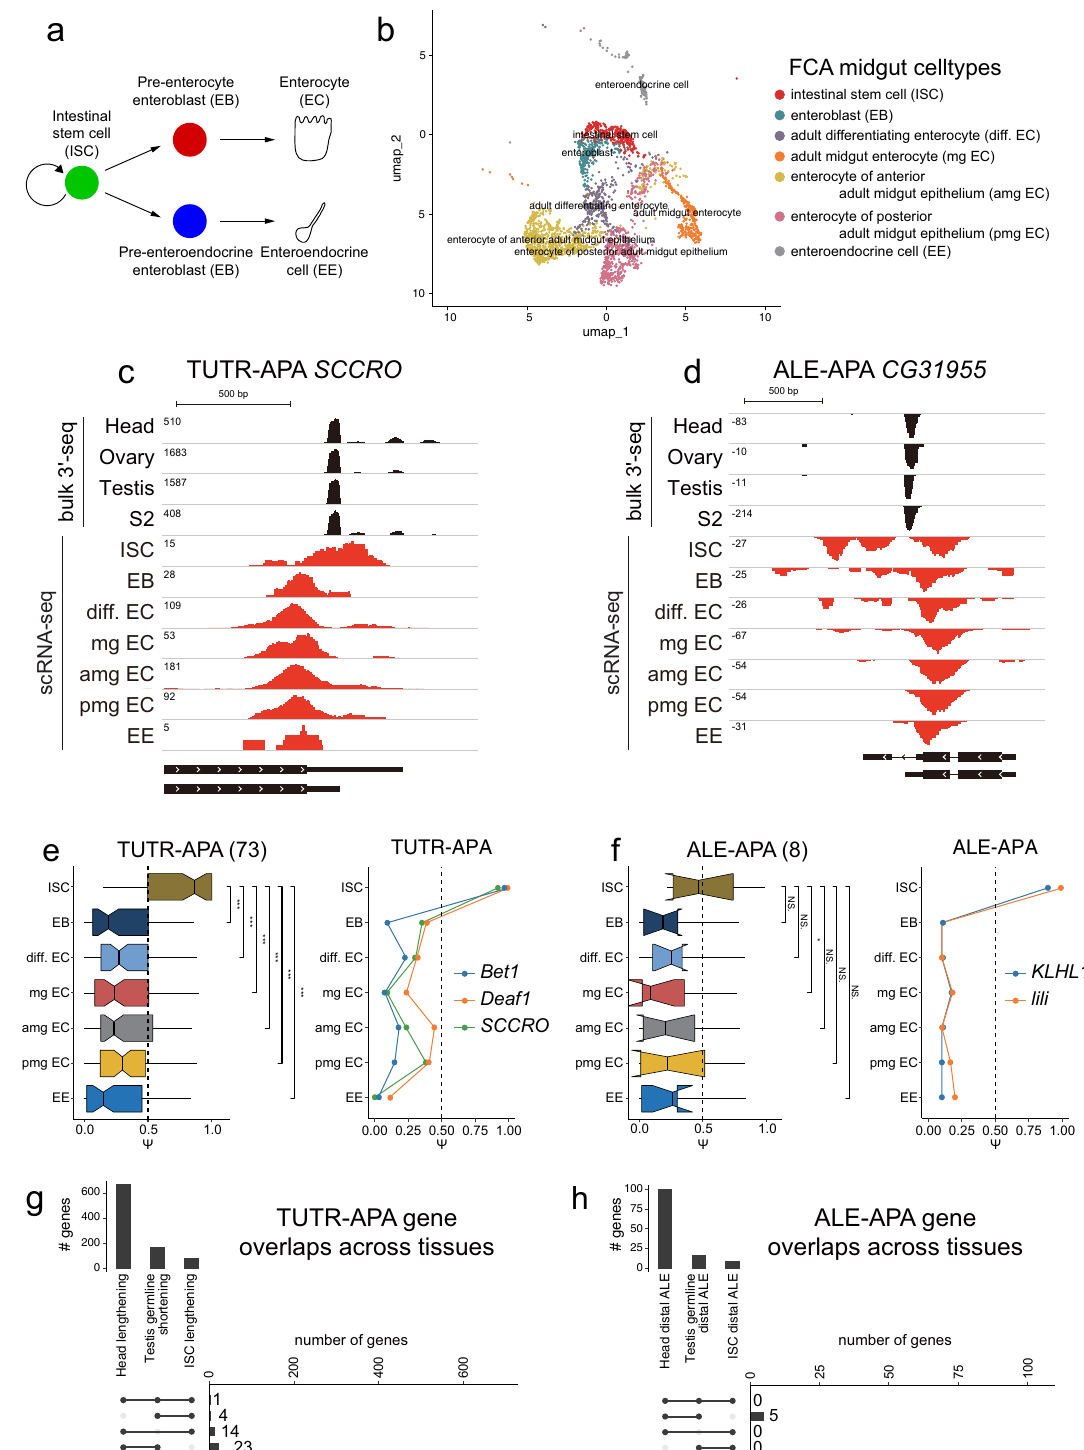
Fig. 5 | Novel 3 ’ processing programs in the intestinal stem cell (ISC) lineage. a Schematic for differentiation of self-renewing ISCs into enterocytes or enter- oendocrinecells. b UMAPoftheISClineagefromintestinalFCAdata. c Exampleofa gene( SCCRO )thatundergoes3 ’ UTRshorteningasISCsdifferentiate. d Exampleof a gene ( CG31995 ) that undergoes distal-to-proximal ALE switching as ISCs differ- entiate. Note in both examples ( c , d ), neurons do not dominantly express the isoforms found in ISCs, suggesting this re fl ects a distinct mechanism to adjust 3 ’